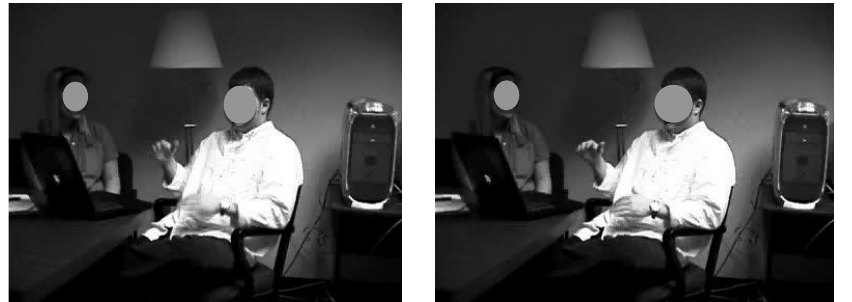
Figure 3. Examples of gesture and the accompanying speech in the four subcategories of two-handed stroke gestures. The bold face in the speech (in quotation marks) indicates where the stroke of the gesture